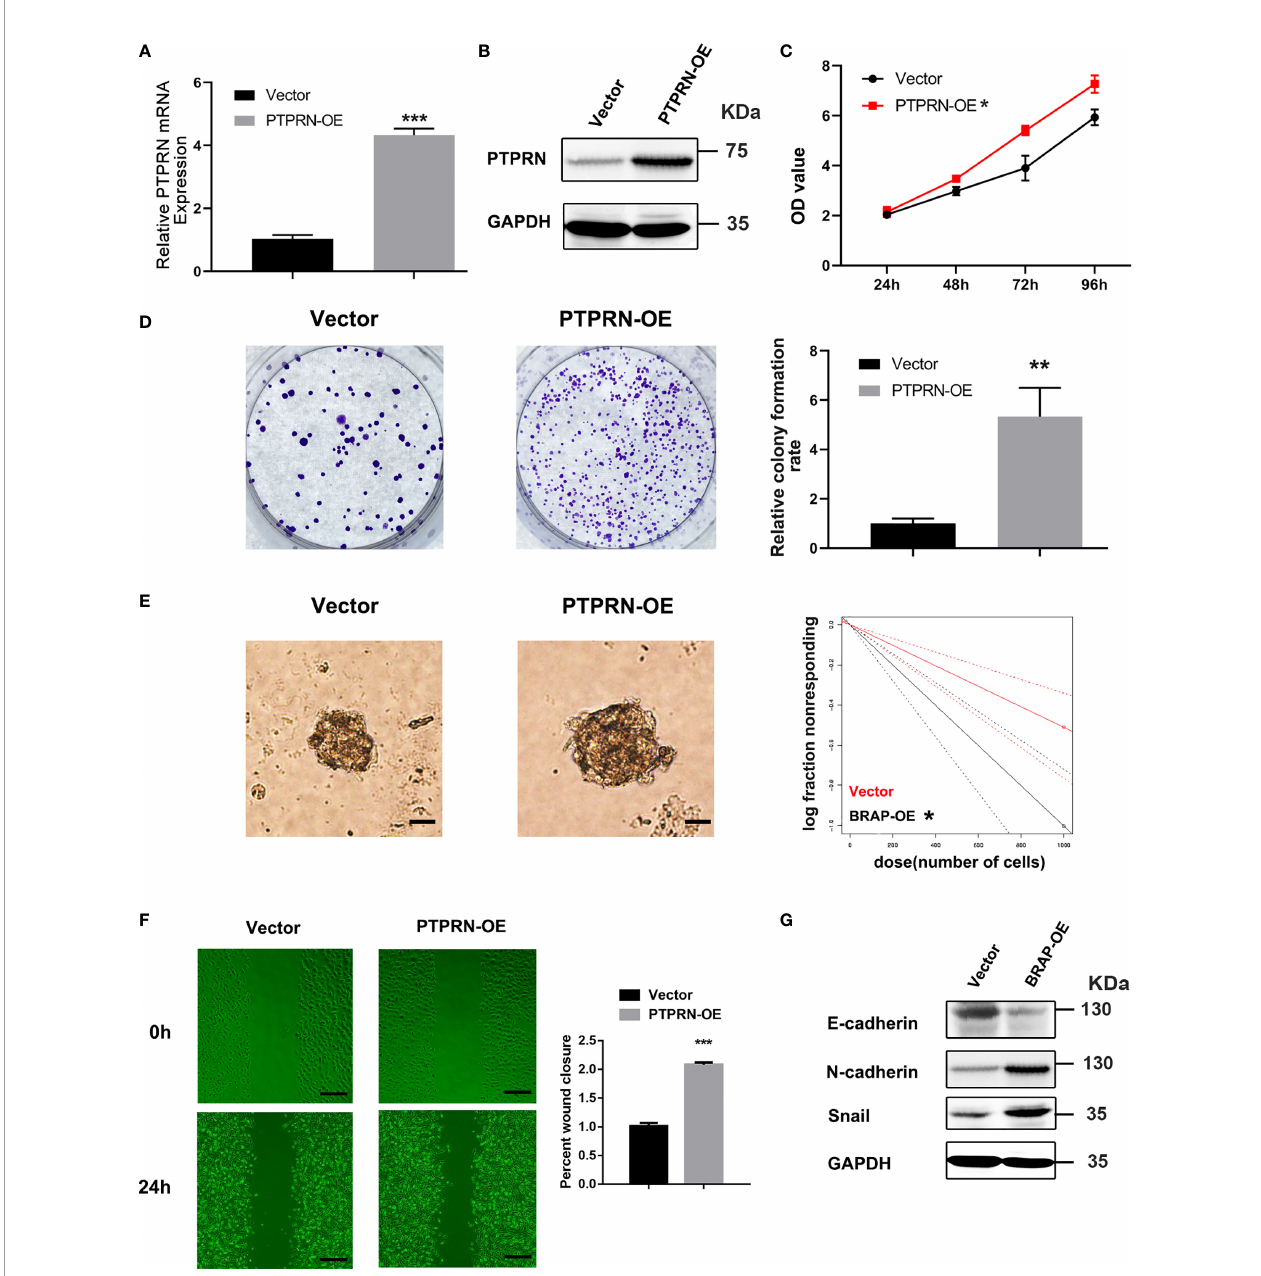
FIGURE 3 | PTPRN overexpression induced the proliferation and migration of U251 cells. (A, B) The level of PTPRN was assayed by RT-qPCR and western blot analysis after the transfection with PTPRN overexpression plasmid; (C) The proliferation of the cells was detected by CCK-8; the corresponding OD values were detected at 24 h, 48 h, 72 h, and 96 h; (D) The proliferation of the cells was detected by colony-formation assays; the results were recorded using a camera at 14 days; (E) Sphere formation detected by microscope and calculated by ELDA after 14 days; (F) Cell migration detected by wound healing assay; the scratch was imaged at 0 and 24 h; The area of scratch reduction was calculated; (G) EMT-related protein (E-cadherin, N-cadherin, and Snail) expression in PTPRN- overexpression U251cells; scale bars, 100 m m; *p < 0.05, **p < 0.01, ***p <